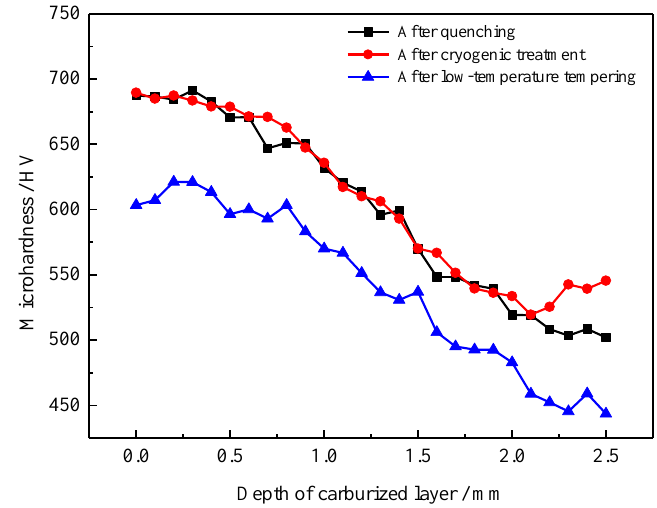
Figure 13. Hardness gradient of the carburized layer for process 2.